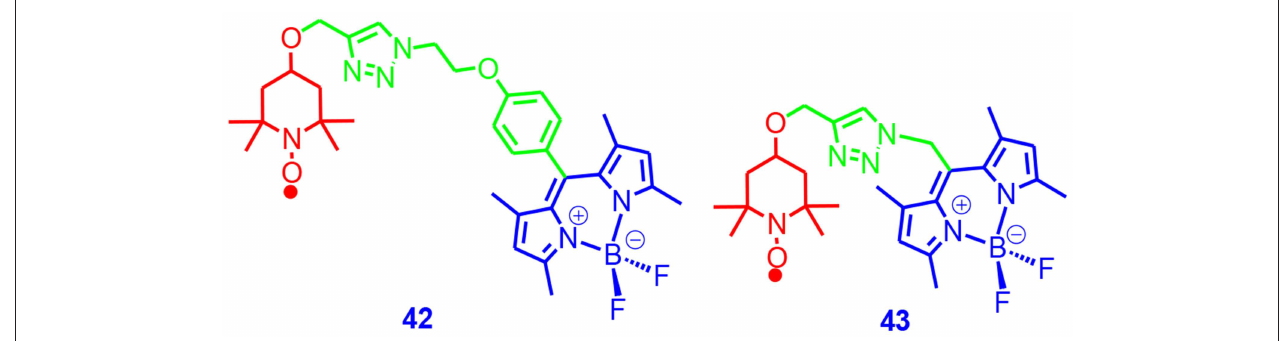
FIGURE 15 | Bodipy-TEMPO dyads showing radical enhanced